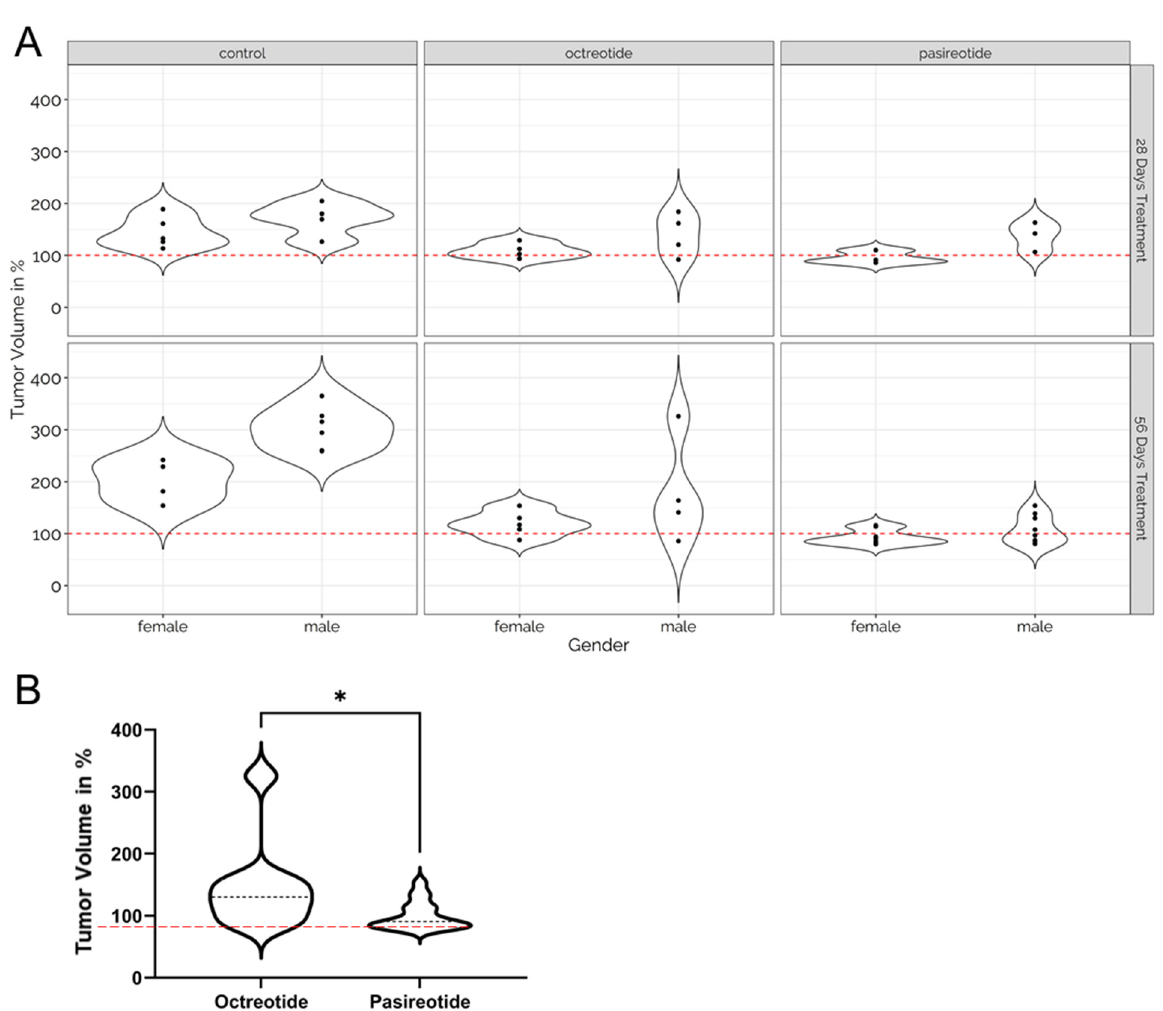
Figure 3. Distribution of the relative tumor volume at the end of the experiment (28 d/56 d). ( A ) Distribution of relative tumor volume changes in rats treated for 28 d (upper row) and 56 d (bottom row) vs. day 0, grouped by treatment and gender. The red dashed line indicates 100%. The distribution is shown as a violin plot. ( B ) Distribution of relative tumor volume changes in octreotide and pasireotide treated rats (56 d) vs. day 0. The red dashed line indicates 100%. The distri- bution is shown as a violin plot, the black dashed line indicates the median. For statistical analysis, the LME model was used. *, p = 0.0088.